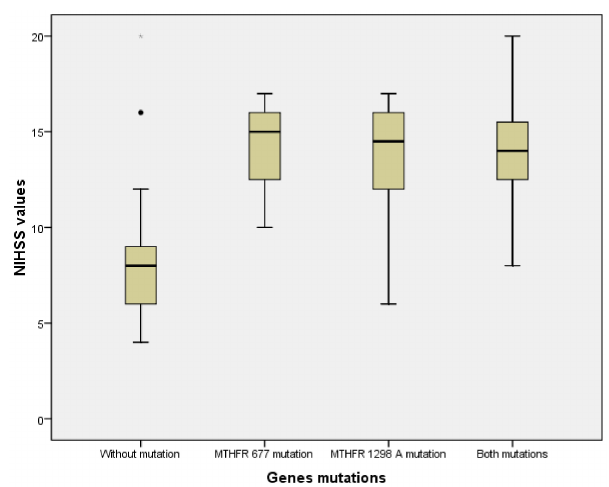
Figure 9. Comparison of NIHSS scores between patients without vs. with one or both MTHFR polymorphisms.